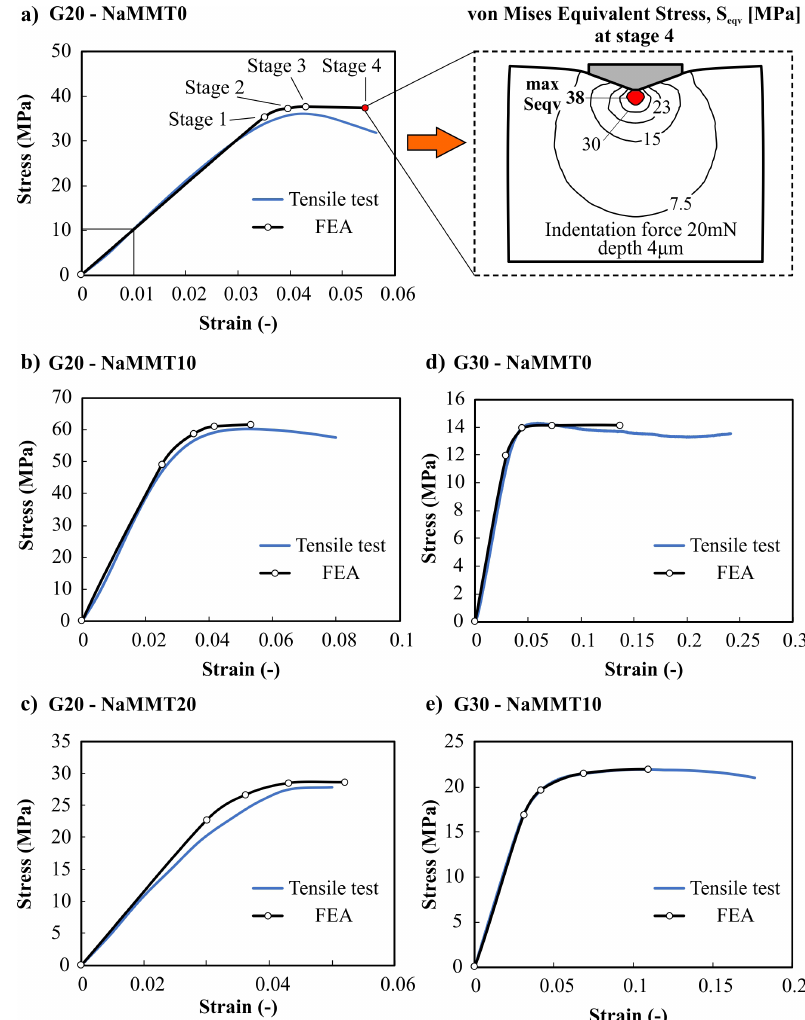
Figure 10. Comparison of the stress-strain curves from FEA simulation with the tensile